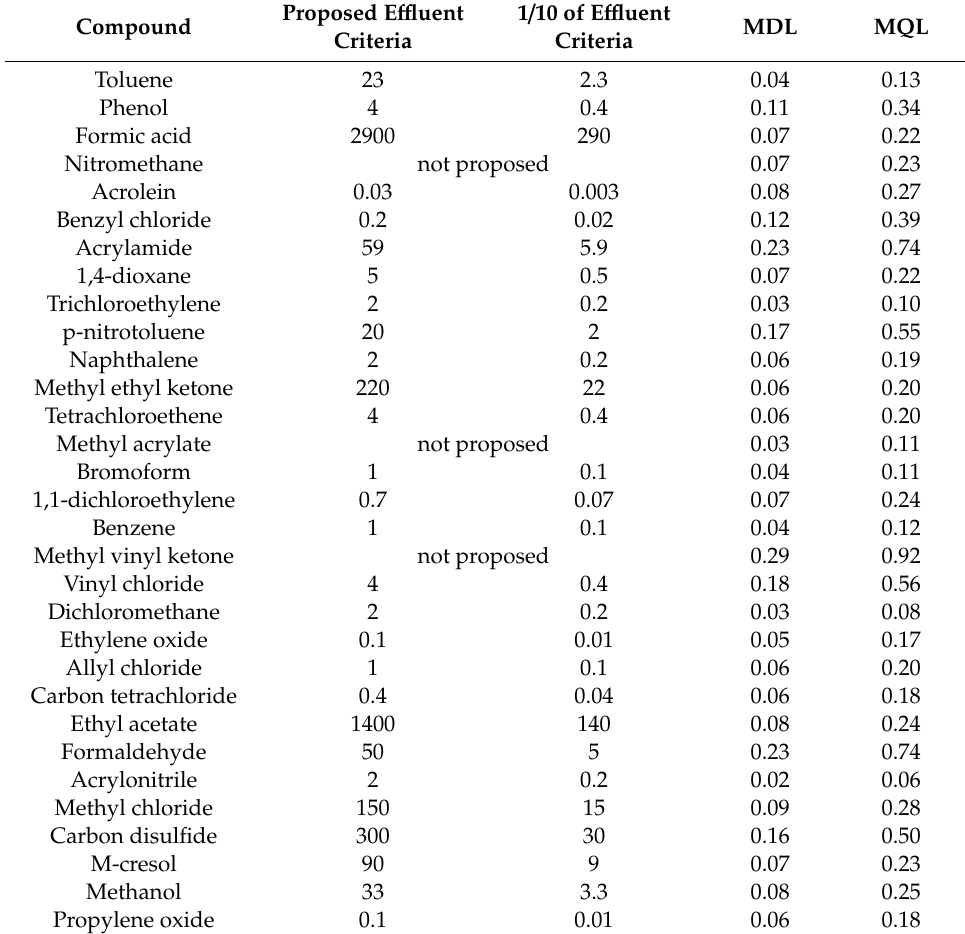
Table 4. MDL and MQL of headspace–SIFT-MS compared with proposed criteria: temporary criteria for inflow blocking of contaminated water